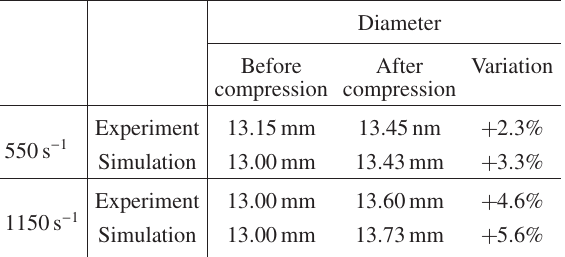
Table 3. Comparison of diameter between before and after